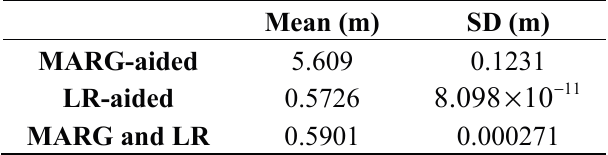
Figure 14. Fault-tolerant capability of the proposed system. Table 5. Statistical analysis of positioning errors during the magnetic